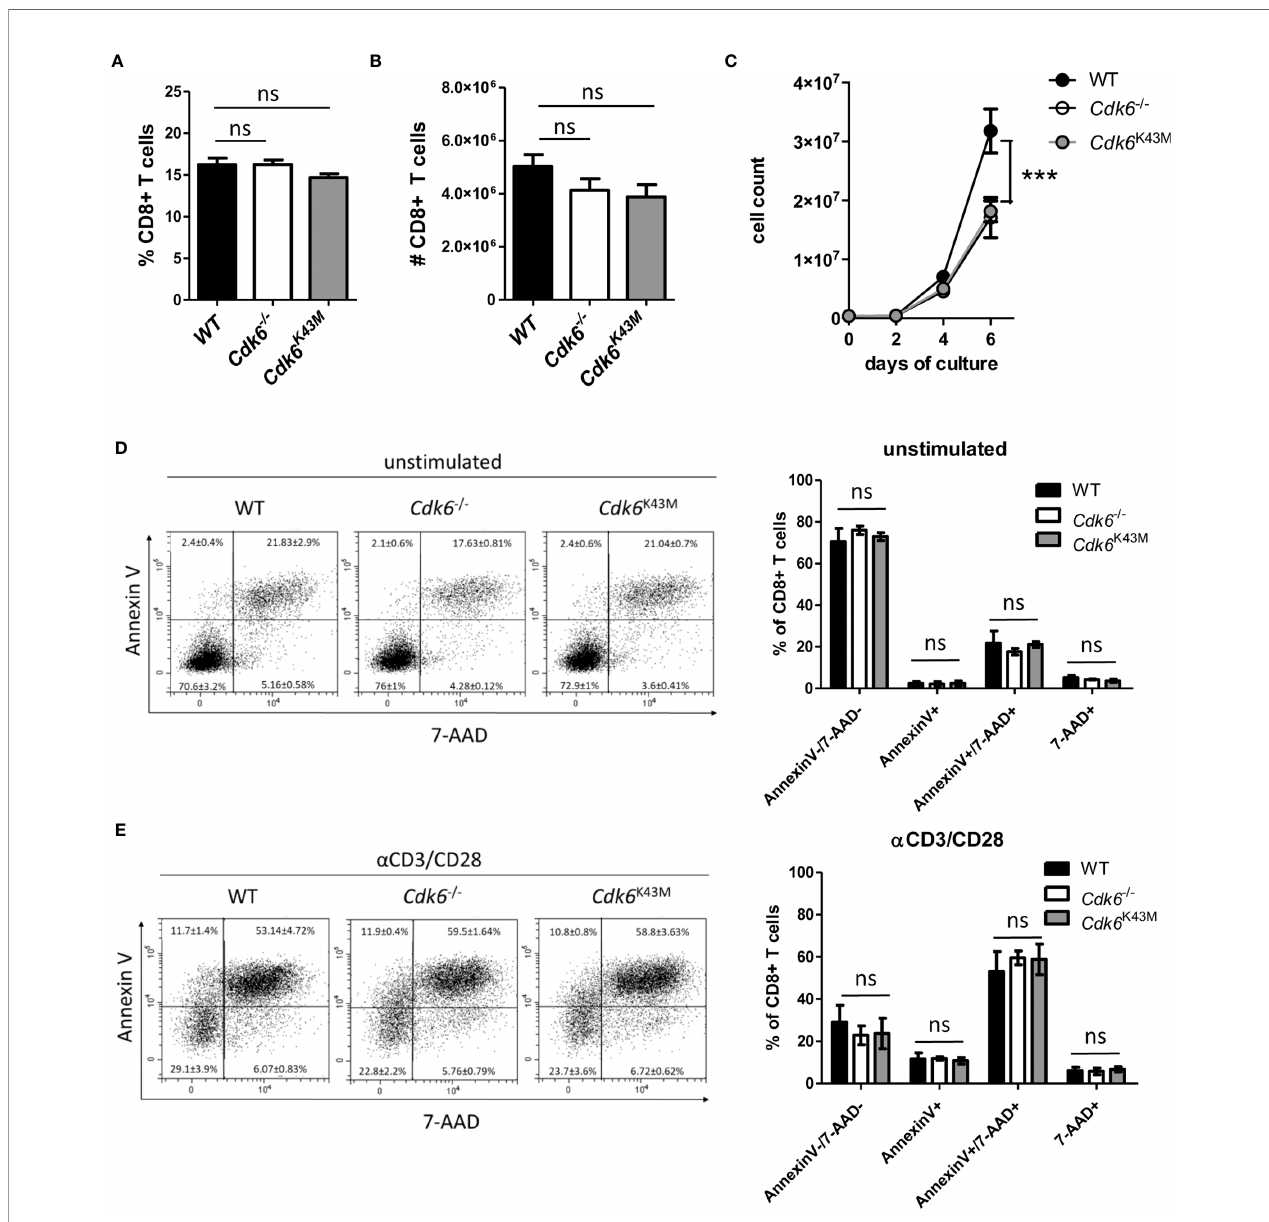
FIGURE 1 | Loss of CDK6 or its kinase activity impairs in vitro expansion of CD8+ T cells. (A, B) Percentage (A) and total numbers (B) of CD3+CD8+ T cells were analyzed by fl ow cytometry in the spleen of WT, Cdk6 - /- and Cdk6 K43M mice (n=8-10). (C) Splenic CD8+ T cells were isolated, activated with a CD3/ a CD28 for 48h and cultured in the presence of IL-2. Numbers of CD8+ T cells were analyzed every two days during culture (n=4). (D, E) Cultured CD8+ T cells were kept unstimulated (D) or re-stimulated with a CD3/ a CD28 (E) for 24h (n=4). Apoptosis was analyzed by fl ow cytometric AnnexinV/7-AAD staining and representative dot blots are shown. (A, B, D, E) Bar graphs represent mean ± SEM, pooled from 2-3 independent experiments. (C) Symbols in growth curves represent mean ± SEM, pooled from two independent experiments; ***p < 0.001 (for comparison on d6), two-way ANOVA. ns, not signi fi